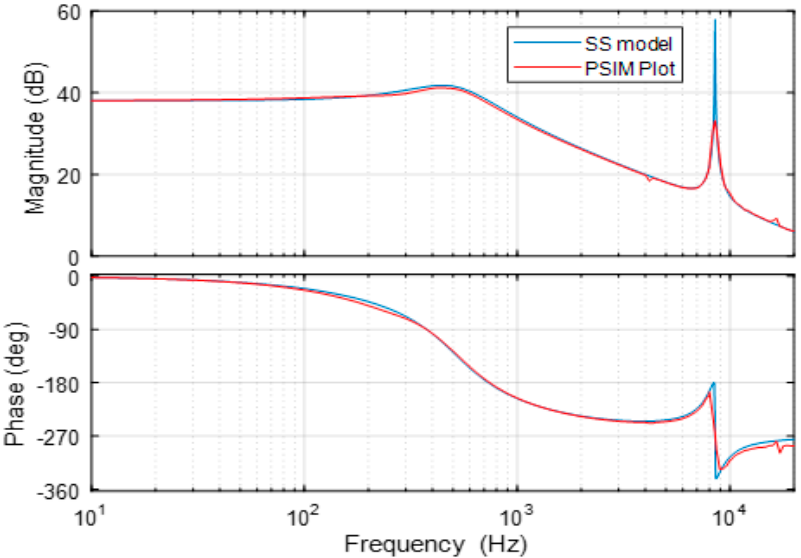
Figure 20. Control-to-output voltage transfer function.